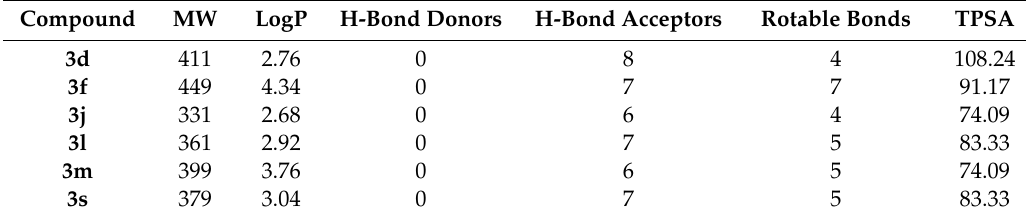
Table 4. Physicochemical descriptors of 3d , 3f , 3j , 3l , 3m, and 3s .